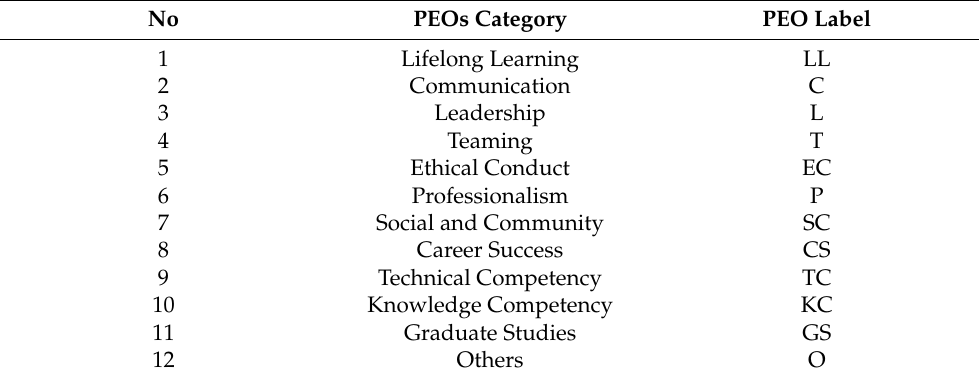
Table 2. PEOs vector space representation (features matrix) .